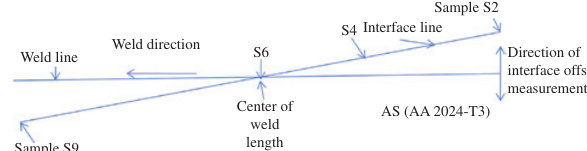
Figure 8: Outline for dissimilar material (between 2024-T3 Al alloy and AZ31B-O Mg alloy) varying interface offset welding (image shown in Figure 5).